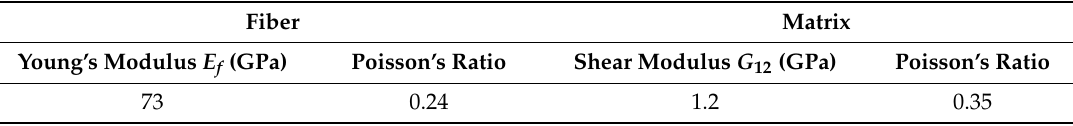
Table 1. Constituent elastic properties used in the Abaqus model (based on material data sheet).